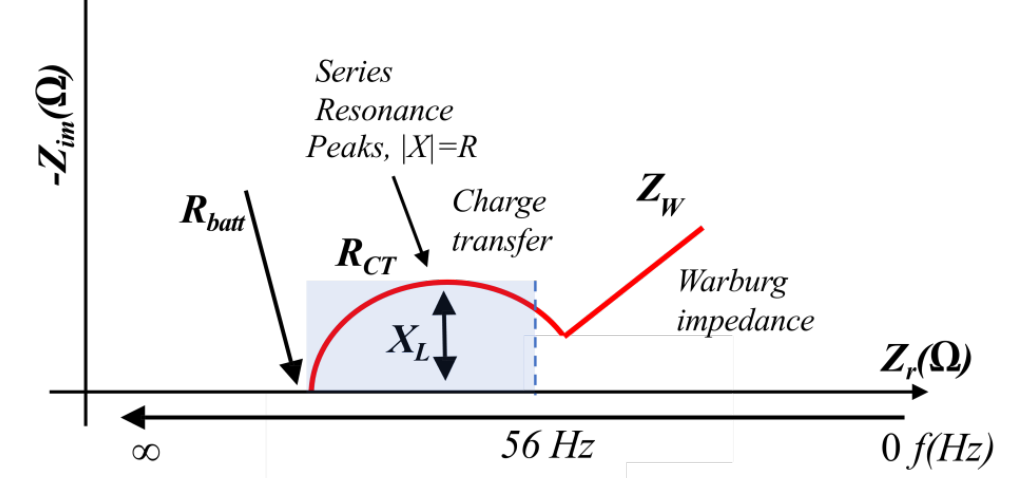
Figure 4. Series LC resonant tank frequency selection.